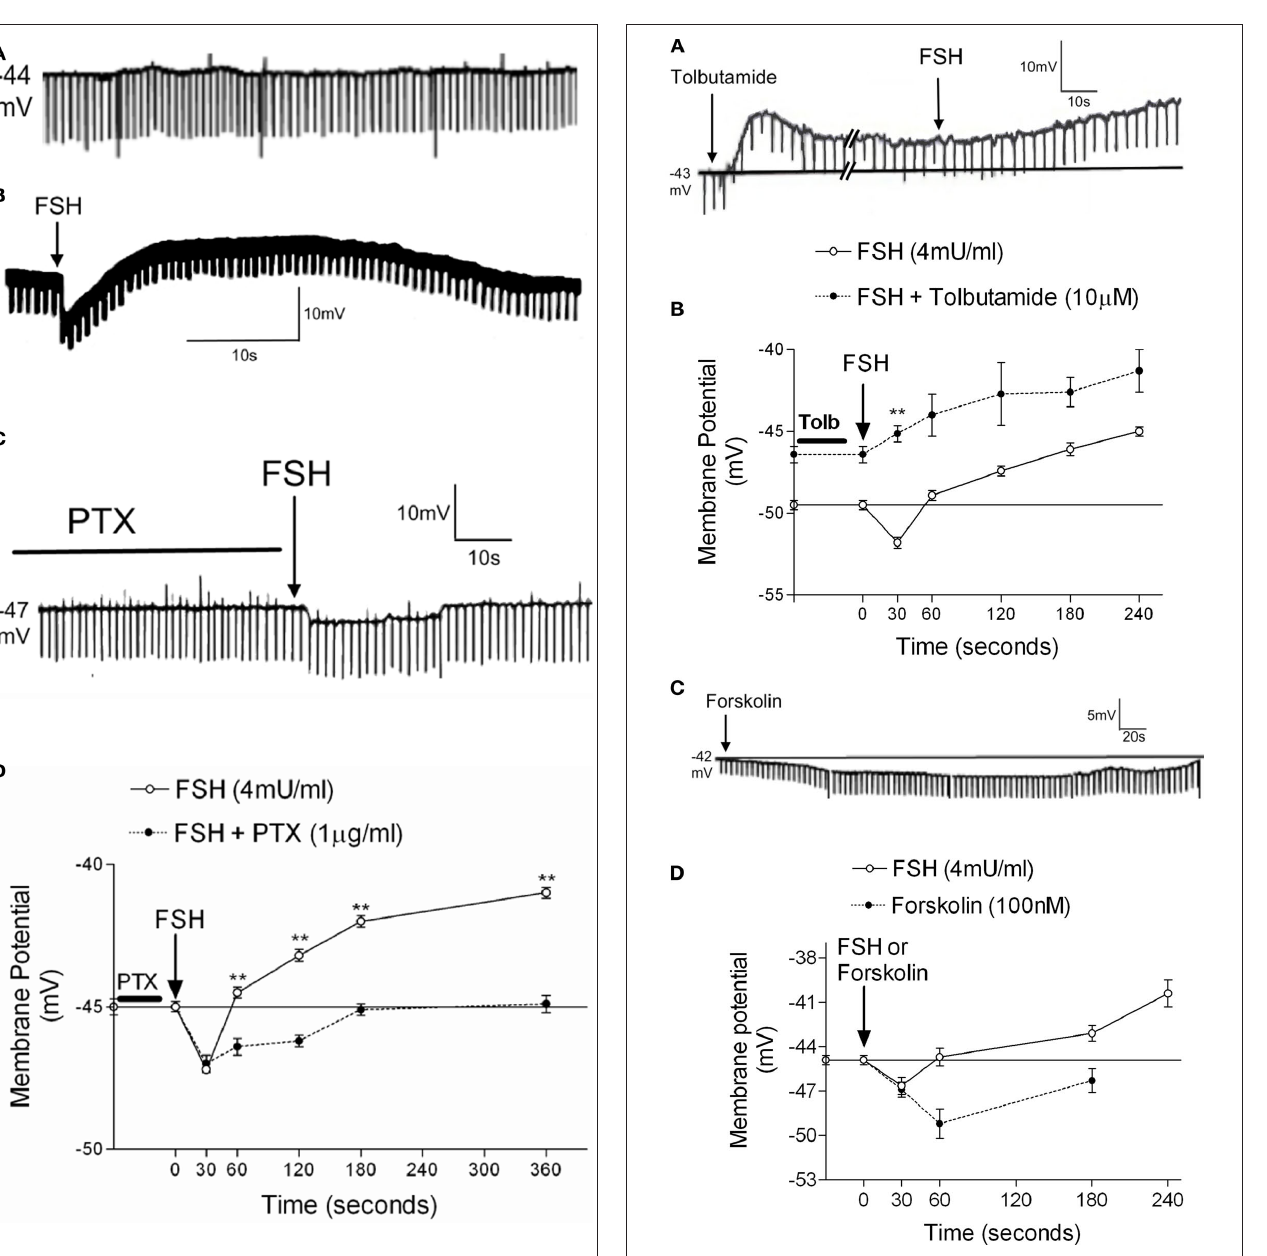
+ channel involvement in the hyperpolarization produced Figure 2 | K ATP by FSH and forskolin on the Sertoli cell membrane. Pre-treatment with = − 44 mV m tolbutamide inhibited the rapid hyperpolarization response without affecting the depolarization phase, register of a representative cell (A) . Changes produced by tolbutamide on the FSH response (B) . Topical application of forskolin (100 nM) produced hyperpolarization on Sertoli cell membrane (C) . Comparison of the FSH and forskolin action on Sertoli cell membrane potential (D) . ** p < 0.001; n = 5 in each treatment (FSH or FSH plus tolbutamide) from five separated